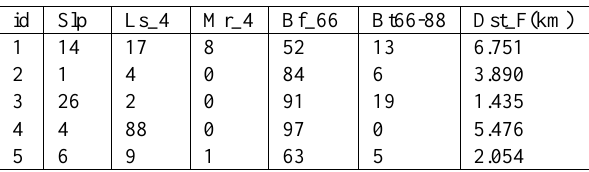
Table 3. Attribute values of five randomly selected statistical units